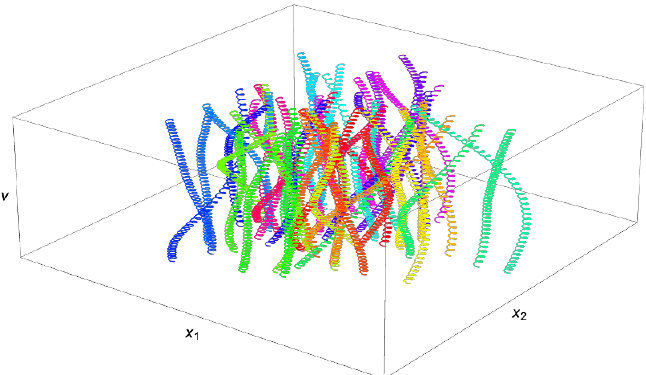
Figure 14. Generic supertube pro(cid:12)le for an NS5-P supertube at low angular momentum, consisting of a single mode of high wavenumber making a tight spiral, together with a generic sprinkling of low wavenumber modes causing a random walk of the pro(cid:12)le on larger scales. The n 5 = 50 (cid:12)vebrane strands have been wound into a single supertube; color adiabatically evolves along the pro(cid:12)le to reveal the supertube’s wandering in the transverse x 1 - x 2